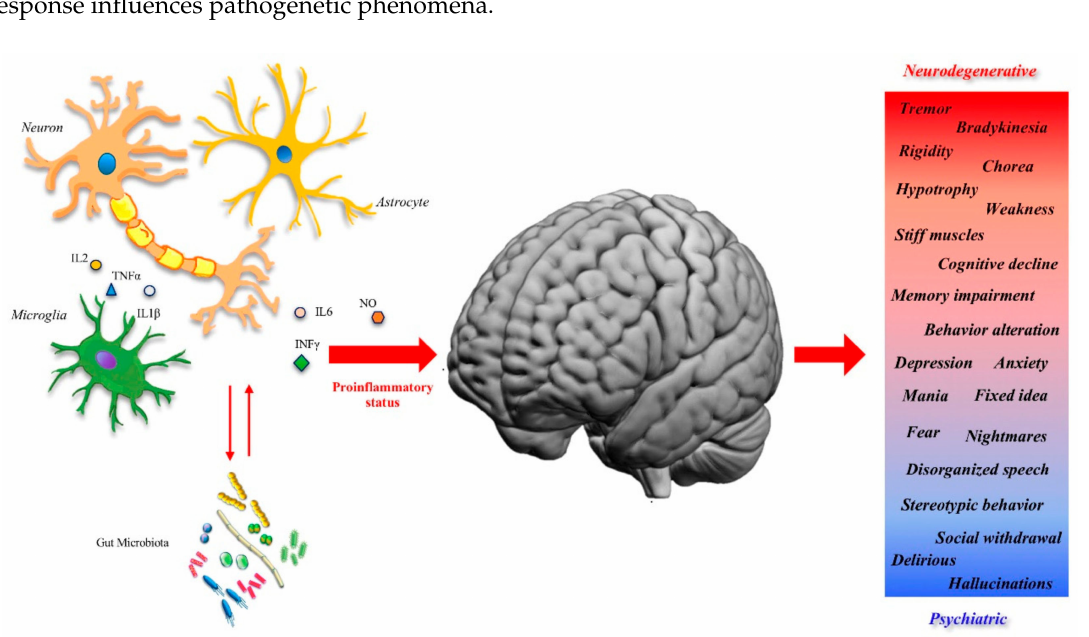
Figure 1. Innate immunity dysregulation is a pathophysiological mechanism shared between neurological and psychiatric brain diseases. As common substrates become clear, the exact distinction between these disorders becomes